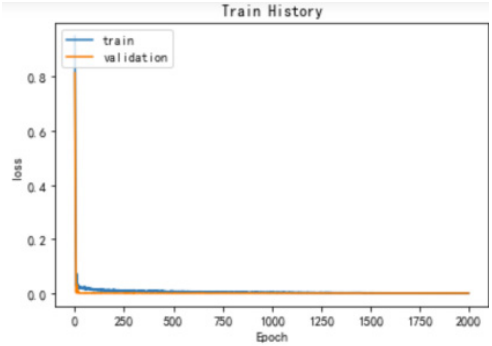
Figure 9. A319 Variation of iteration number error.